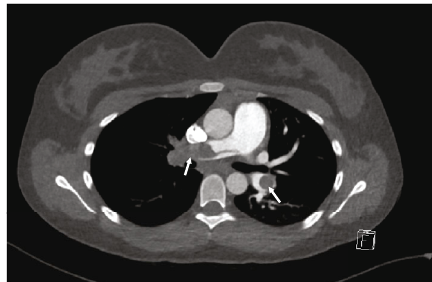
Figure 1: CTPA prior to thrombolysis with pulmonary embolism present